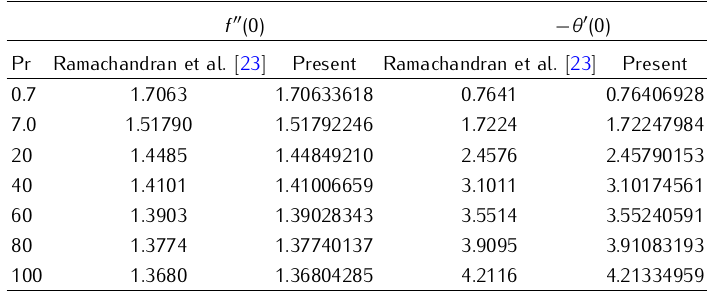
Table 1. : Comparison of f 00 (0) and θ 0 (0) for various values of Pr calculated by the present method and that of Ramachandran et al. [23] for N